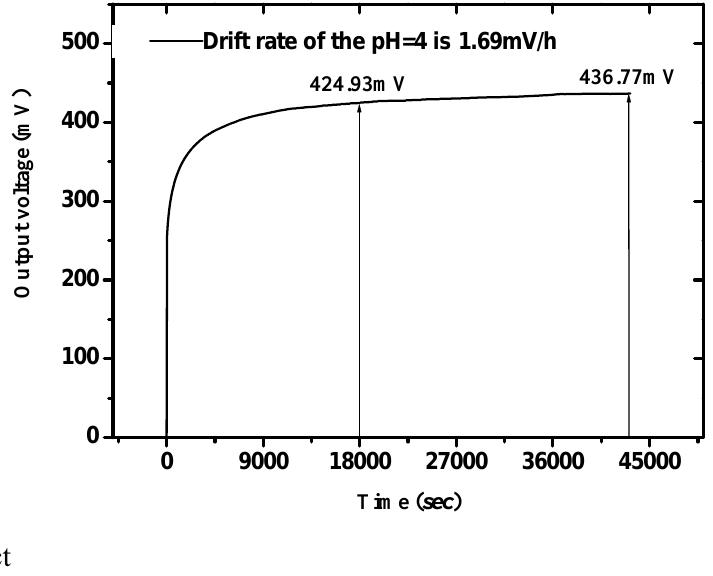
Figure 7. Drift rate of RuN pH sensor in pH 4 buffer solution for measuring 12